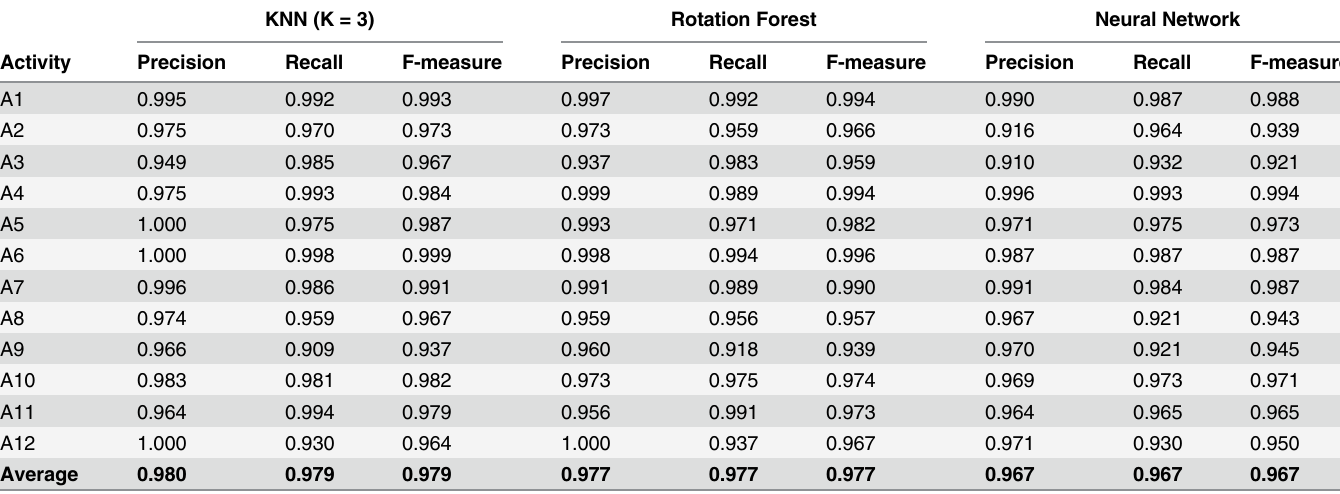
Table 10. Classification results of three classifiers on FS5 features